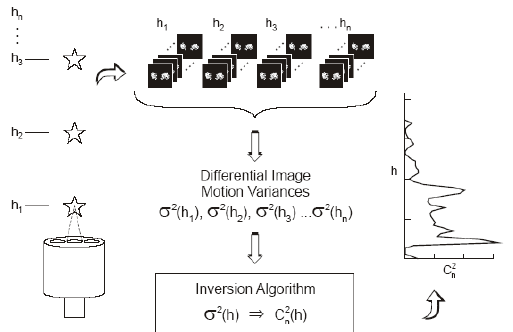
Fig. 5 The principle for remote sensing